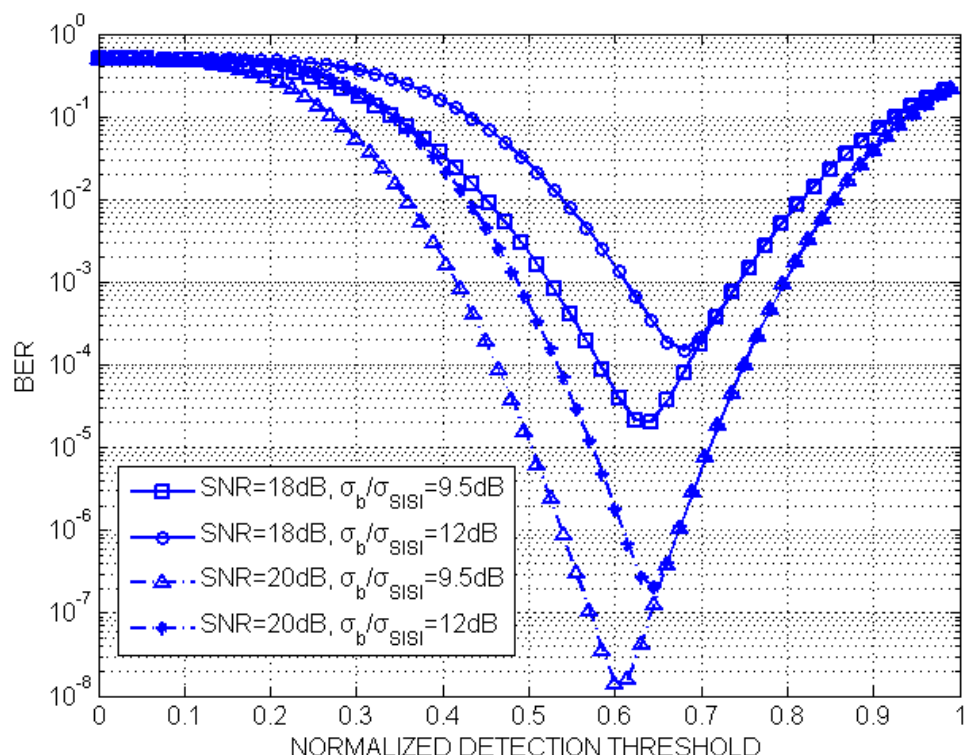
Figure 12. The BER curves of different focal lengths of the